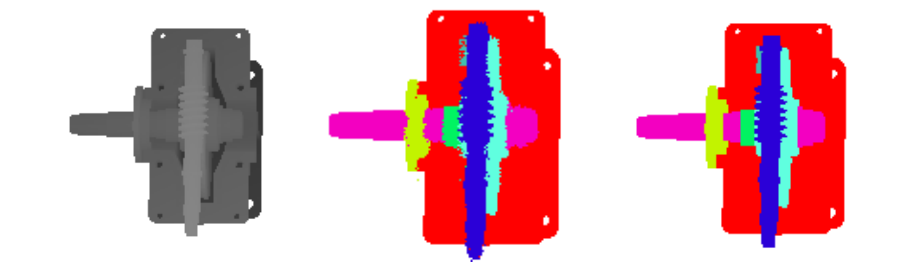
Figure 18. Depth image segmentation of gear reducer.